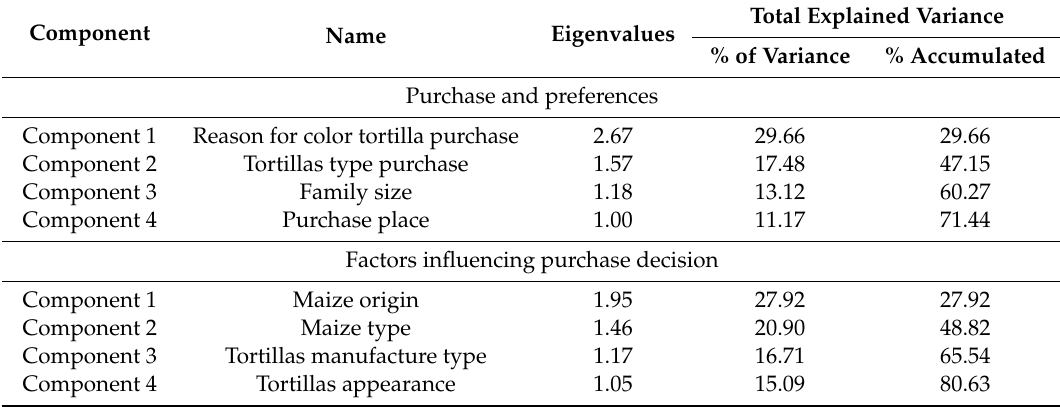
Table 3. PCA with the correspondent eigenvalues and the percentages of variance explained.